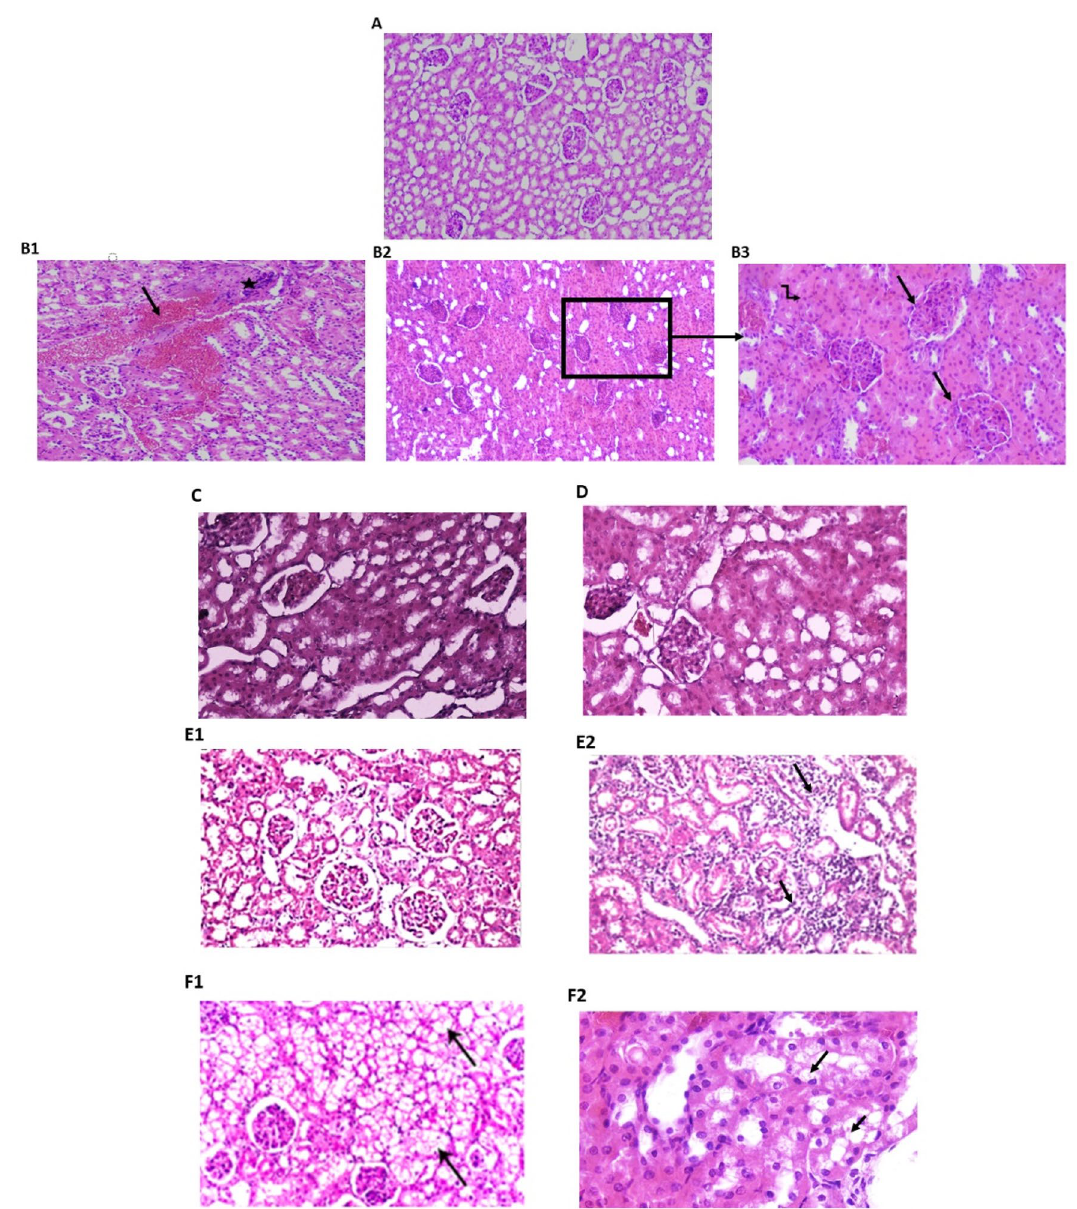
Figure 5. Photomicrograph of kidney tissue sections in different studied groups. (H&E) ( A ) control group with normal histological structure of glomeruli and tubules (H&E ×200); ( B1,B2 ) model group (dexamethasone- treated group) interstitial hemorrhage (arrow) ×100, hypercellular glomeruli (arrow) in ( B3 ), ×400, obliterated tubules by swollen epithelial cells (zigzag arrow in B3 ); ( C ) PRV 0.5 mg/kg showing focally shrunken glomeruli and focally swollen hyalinized epithelial cells lining the tubules; ( D ) PRV1 mg/kg with well-formed glomeruli and tubules; ( E ) PRV 2 mg/kg exhibited a nearly normal histological renal pattern ( E1 , ×200) (arrows) with some inflammatory infiltrations (arrow E2 ); ( F ) losartan-treated group showing improved glomerular picture with interstitial vacuolation ( F1 , arrows), swollen hyalinized epithelial cells lining the tubules (arrows) were observed ( F2 ,